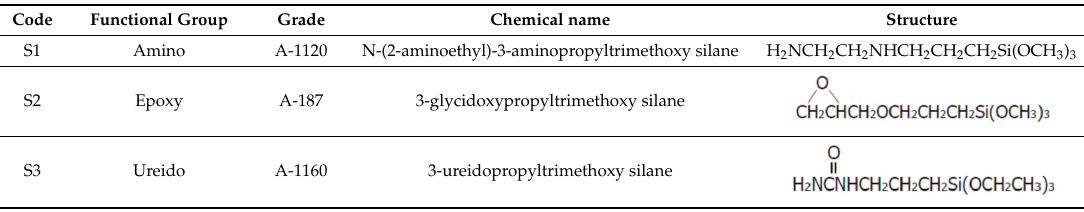
Table 1. Code, functional group, grade and chemical name of silane coupling agents used in this study.